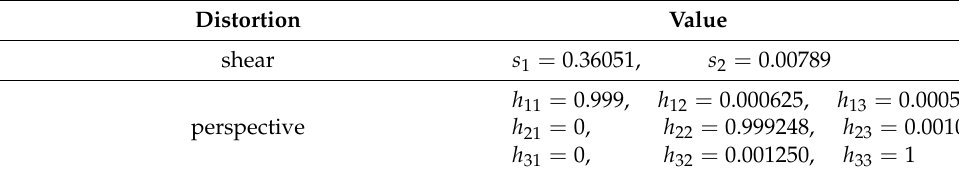
Table 4. Parameters of star image